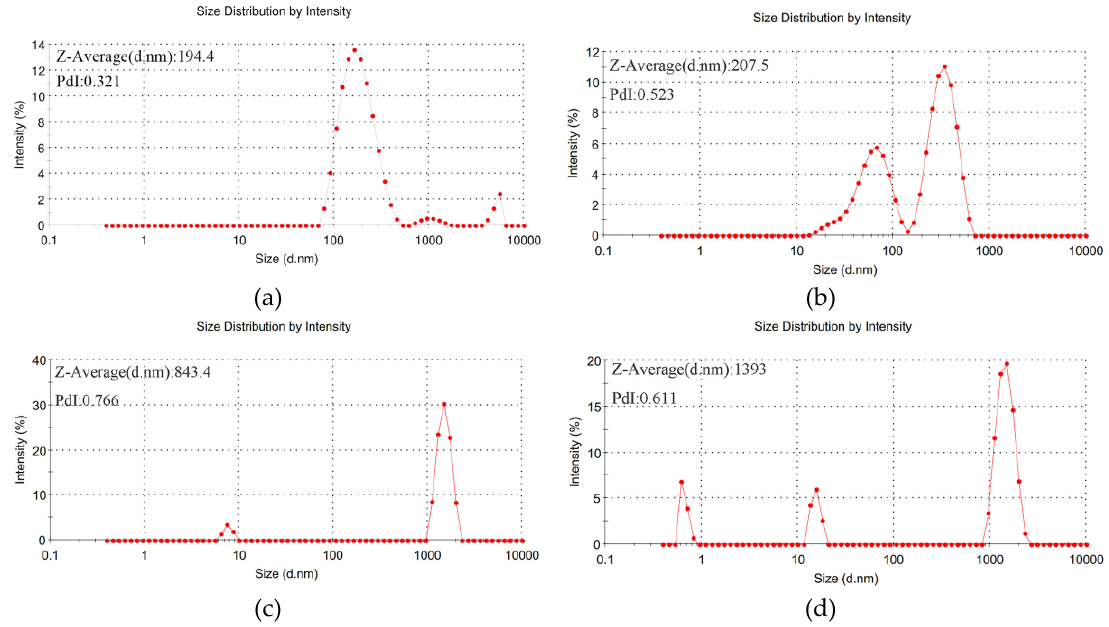
Figure 2. Particle size and distribution of 25 μmol/L E-C in 0.3 mol/L Na 2 CO 3 /PEG2000. ( a ) 0.20 g/mL PEG2000; ( b ) 0.23 g/mL PEG2000; ( c ) 0.25 g/mL PEG2000; ( d ) 0.30 g/mL PEG2000.